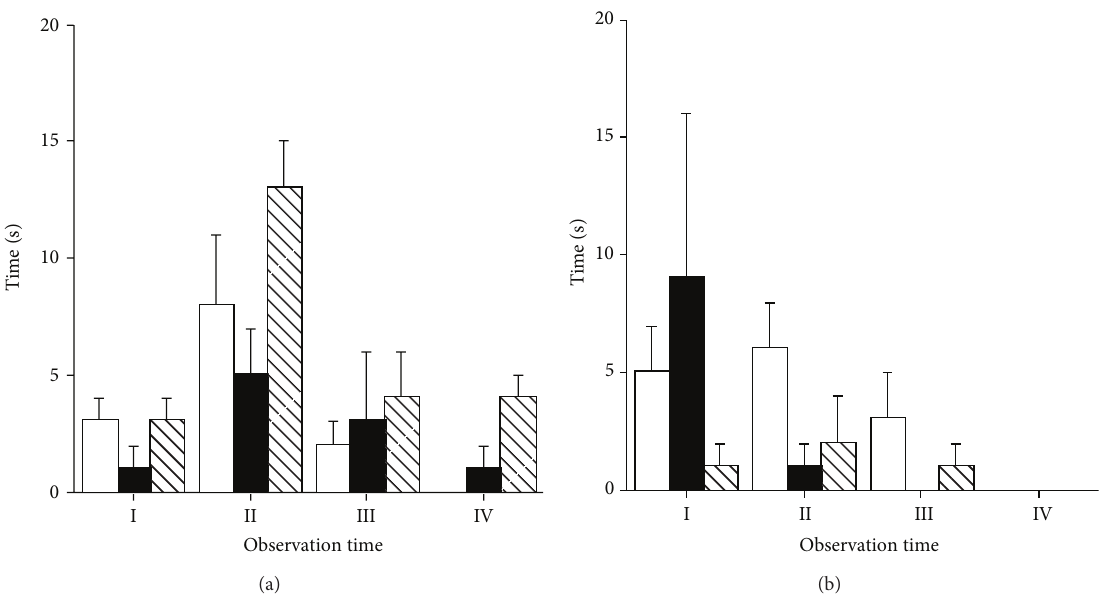
Figure 4: Effect of different types of physical exercise (race blank; maximal exercise shaded; daily exercise lined) on urinating (a) and defecating activity (b) of Standardbred horses housed in single stalls. Mares were examined at rest in their stalls (Time I), immediately after exercise (Time II), one (Time III), and two hours (Time V) after the completion of exercise. Values are expressed as means ± SE.